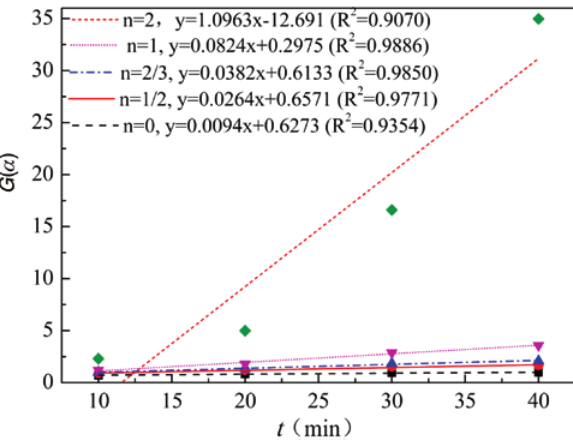
Figure 10: The relationship between G ( α ) and time at 650 ° C on n = 0, 1/2, 2/3, 1, 2, respectively.